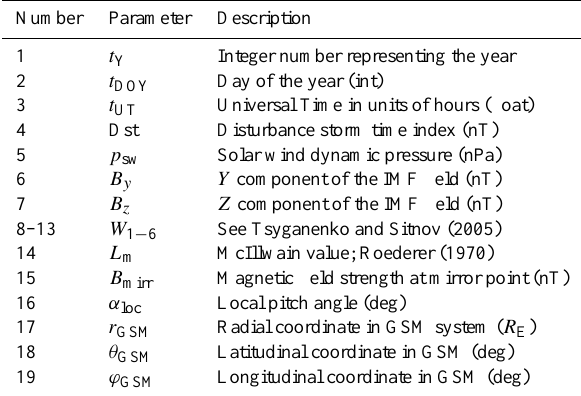
Table 1. Input parameters for the neural network LANLstar